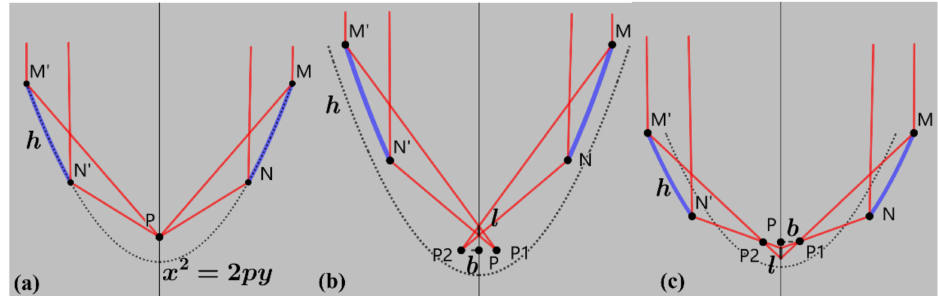
Figure 3. Parabolic mirror schematics: ( a ) Principle of conventional parabolic mirror; ( b ) Parabolic mirror with inwardly deviated focus; ( c ) Parabolic mirror with outwardly deviated focus.